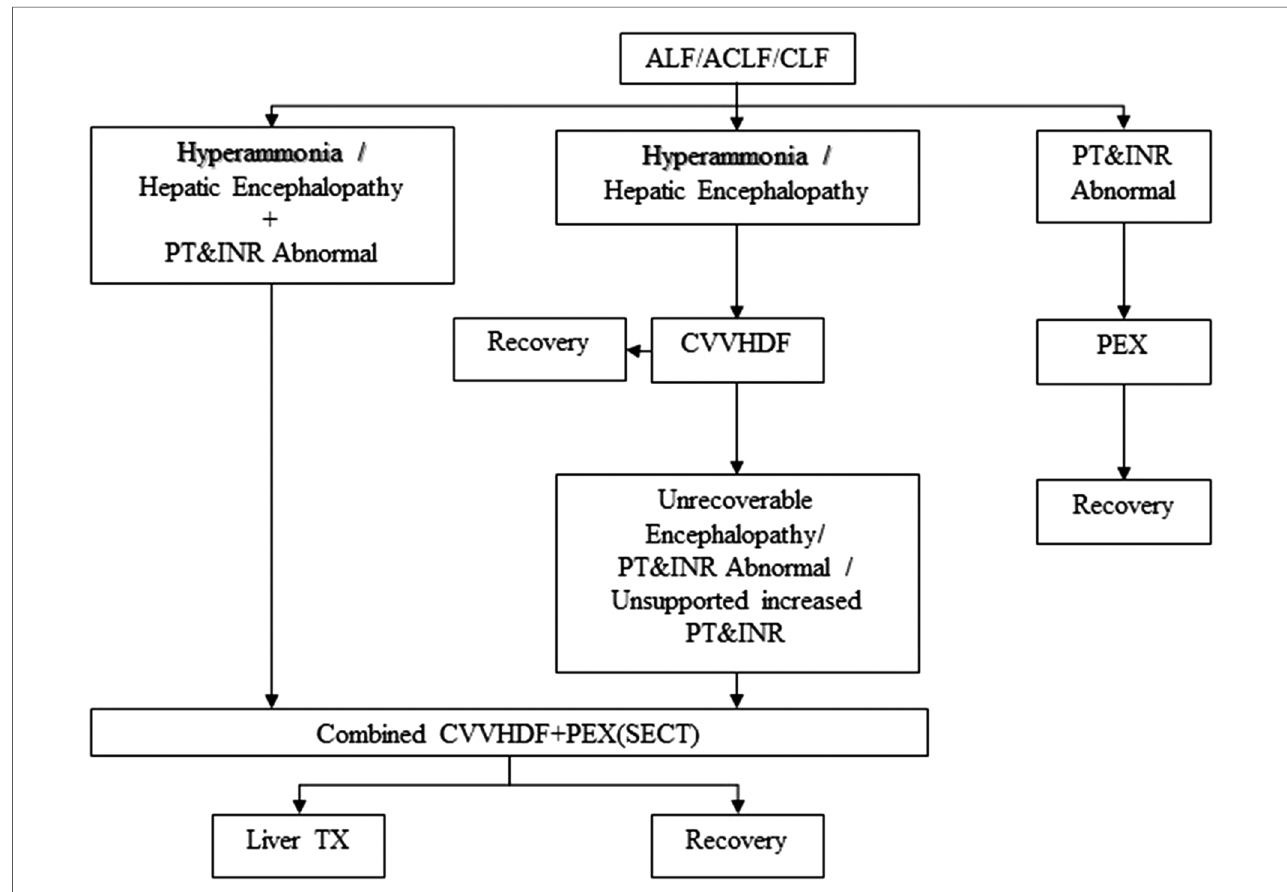
FIGURE 2 ECT protocol for ALF, ACLF, or CLF. ECT, extracorporeal therapy; ALF, acute liver failure; ACLF, acute-on-chronic liver failure; CVVHDF, continuous veno- venous hemodia fi ltration; CLF, chronic liver failure; PEX, plasma exchange; PT, prothrombin time; INR, international normalized ratio; Liver TX, liver transplantation; SECT, supportive extracorporeal